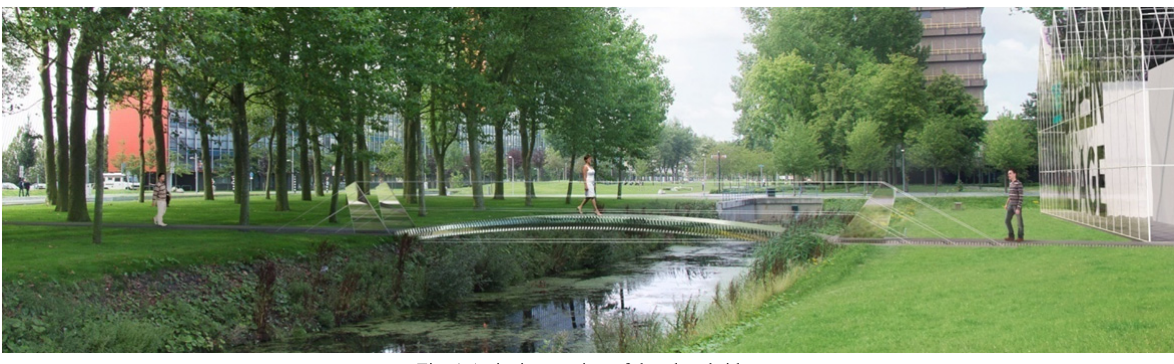
Fig. 1 Artist impression of the glass